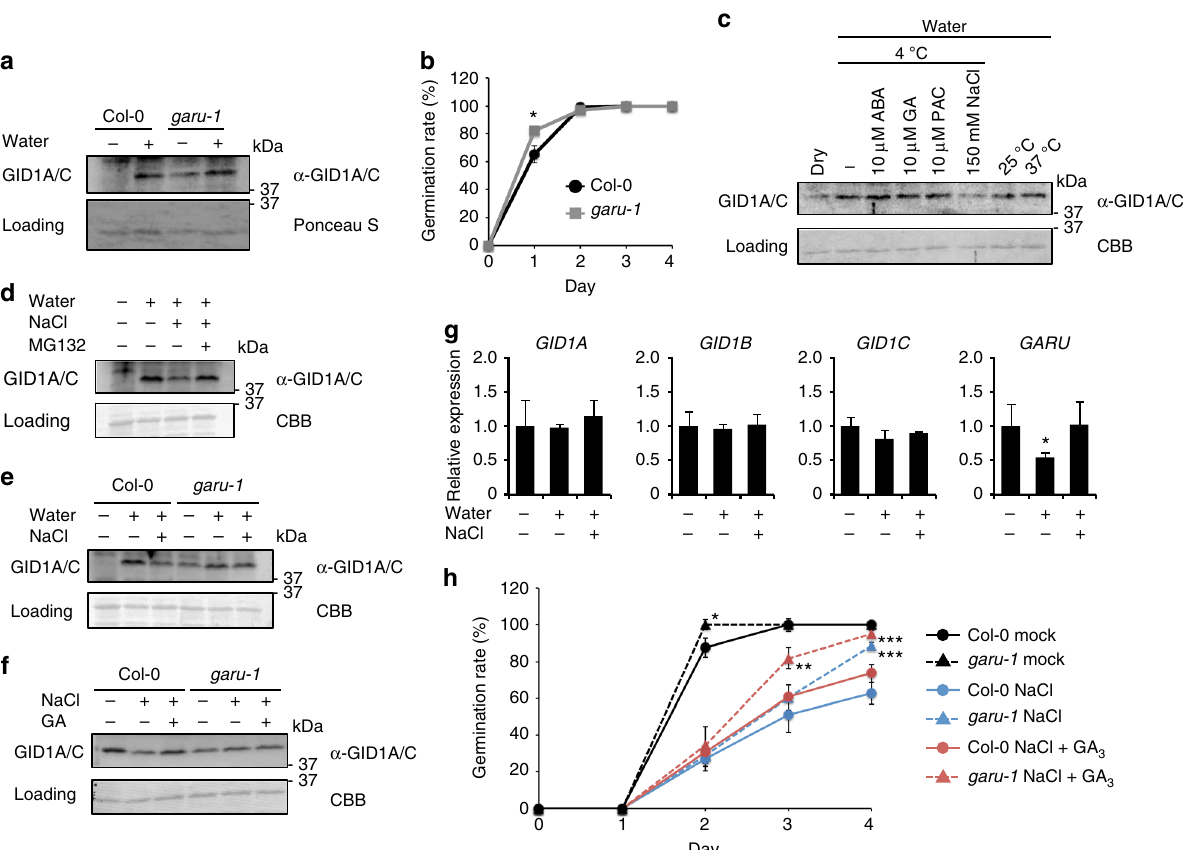
Fig. 7 GARU mediate sensitivity of GA response in the seed under the salt stress. a Immunoblot analysis of GID1A/C in Col-0 and garu-1 seeds that were treated with (+) or without ( − ) of water for 12 h at 4 °C. b Germination ef fi ciency of Col-0 and garu-1 seeds in water. c Immunoblot analysis of GID1A/C in the Col-0 seeds. Seeds were incubated in the indicated conditions for 12 h. d – f Salt-mediated instability analysis of GID1A/C in seeds by immunoblot analysis. After incubation of Col-0 seeds with (+) or without ( − ) of water and 150 mM NaCl solution for 12 h at 4 °C, seeds were incubated with 40 μ M MG132 for 6 h ( d ). The Col-0 and garu-1 seeds were incubated with (+) or without ( − ) of water and 150 mM NaCl solution for 12 h at 4 °C ( e ), and then seeds were treated with 10 μ M GA 3 for 6 h ( f ). g RT-qPCR analysis of GID1A , GID1B , GID1C , and GARU genes in Col-0 seeds. Seeds was treated with (+) or without ( − ) of water or 150 mM NaCl solution for 12 h at 4 °C. Transcript levels were normalized to the level of UBC21, and relative transcript level in untreated seeds as one. Experiment had three biological repeats and the average value is shown with s.e.m. ( n = 9). Statistically signi fi cant changes compared with dry seeds are indicated ( *P < 0.05, two-tailed Student ’ s t -test). h Germination ef fi ciency of Col-0 and garu-1 seeds under the salt stress condition. After strati fi cation in 150 mM NaCl solution or water for 2 days at 4 °C, seeds were germinated on solid medium containing with or without (mock) of 150 mM NaCl or 150 mM and 10 μ M GA 3 . The percentage seed germination (de fi ned by radicle protrusion) was measured every 24 h after strati fi cation. Data are means ( ± s.d.) of three independent experiments of 50 seeds each are presented ( n = 3 in Fig. 7b and n = 6 in Fig. 7h), and statistically signi fi cant changes compared with Col-0 under the same conditions are indicated ( *P < 0.05, 0.01 < **P < 0.05, *** P < 0.01, two-tailed Student ’ s t -test) ( b , h regulated by GARU-dependent GID1 ubiquitination and posi- tively regulated by TAGK2 through Tyr phosphorylation and inactivation of GARU. Furthermore, our study suggested that